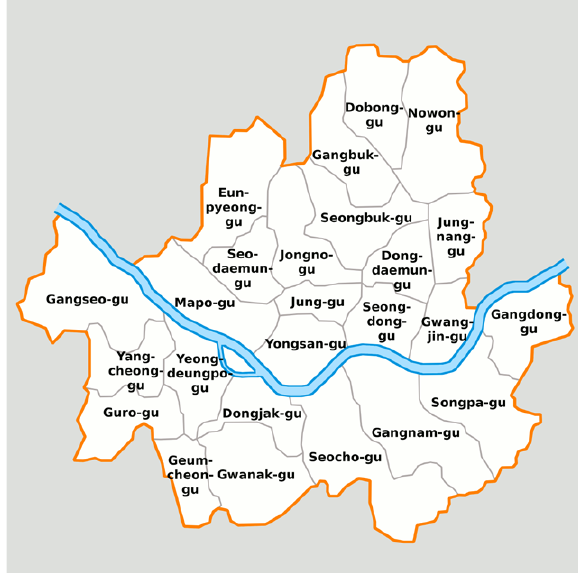
Figure 5. A map of Seoul, Korea (source: Wikimedia Commons, 2005)